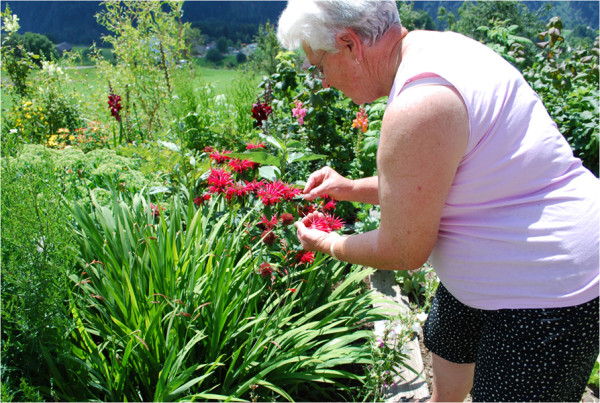
 Woman pickingMonarda dydimain her garden for tea (Photo: Susanne Grasser).